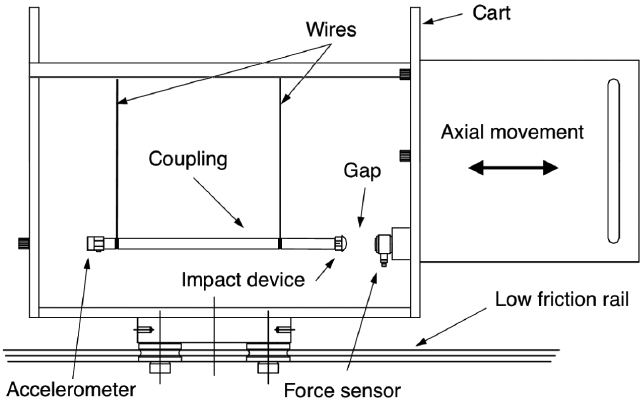
Fig. 3. Test rig: Cart and hammer